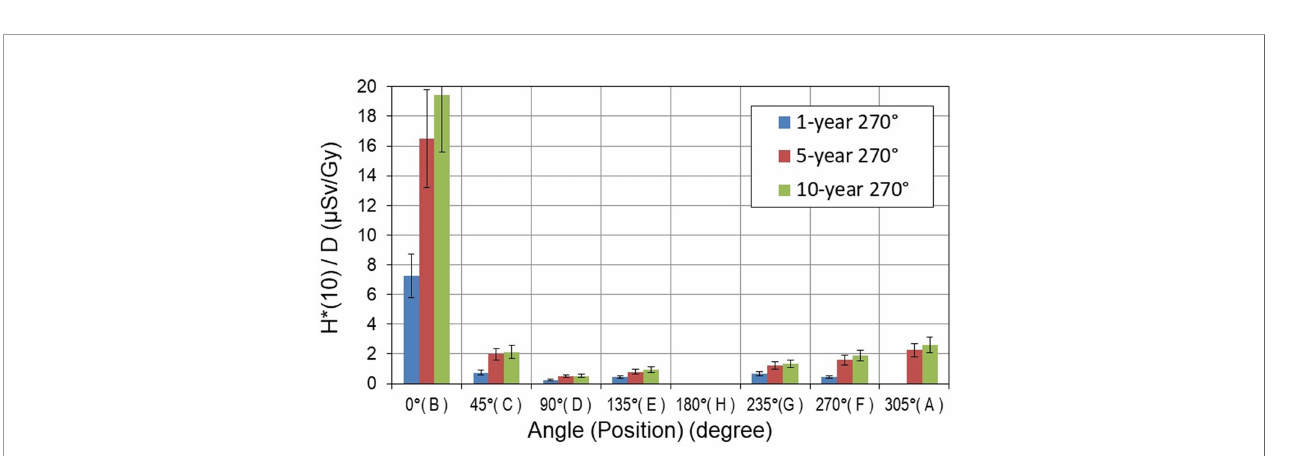
FIGURE 7 | Neutron ambient dose equivalent H *(10) per treatment Gy [ m Sv/Gy] measured around pediatric phantoms at 270° gantry position. The error bars represent the standard deviation.